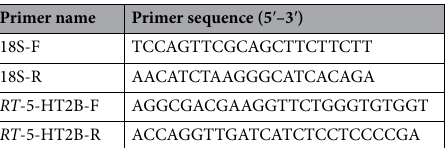
Table 4. Primers were selected for evaluating 5-HT2B expression level with